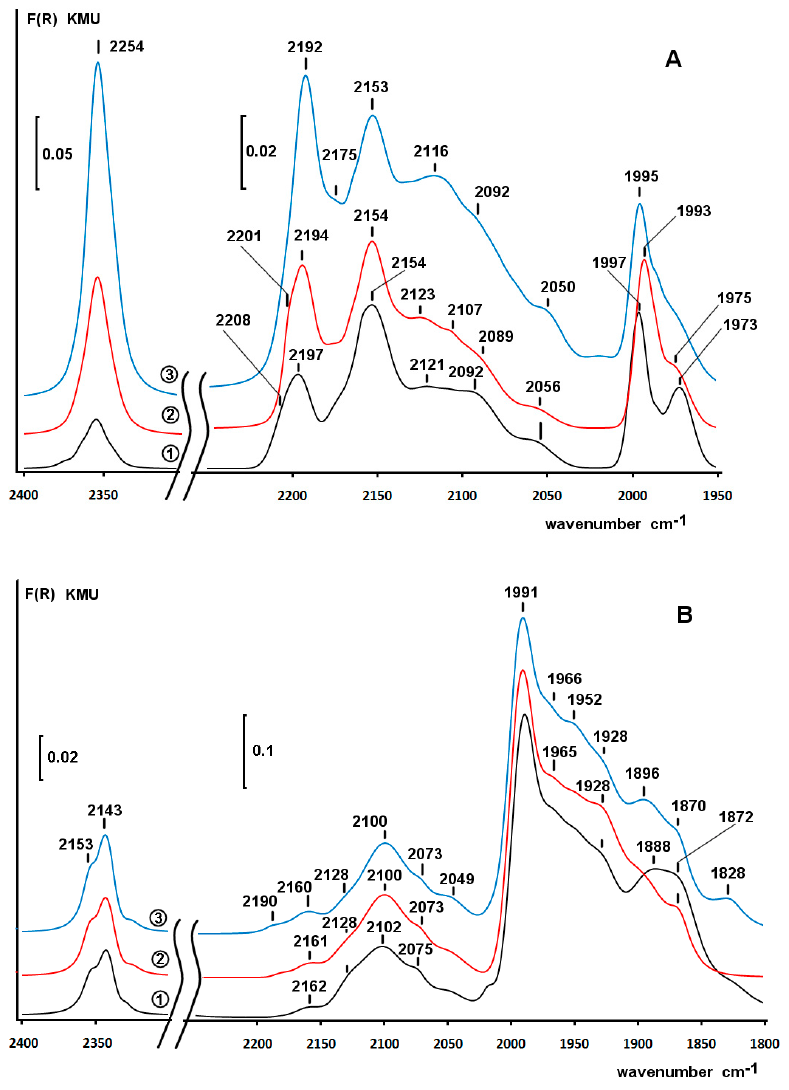
Figure 5. Difference DRIFT spectra of CO adsorbed at room temperature on Pd/ZS(550) before ( A ) and after H 2 treatment at 330 °C ( B ). CO pressure: 5 Torr—curve 1, 20 Torr—curve 2, 50 Torr—curve 3. F(R)—Kubelka–Munk function (Kubelka–Munk units). The band at 2089–2092 cm − 1 corresponded to linear Pd 0 –CO complexes, and the band at 2050–2056 cm − 1 to linear CO complexes of palladium atoms localized on the edges,